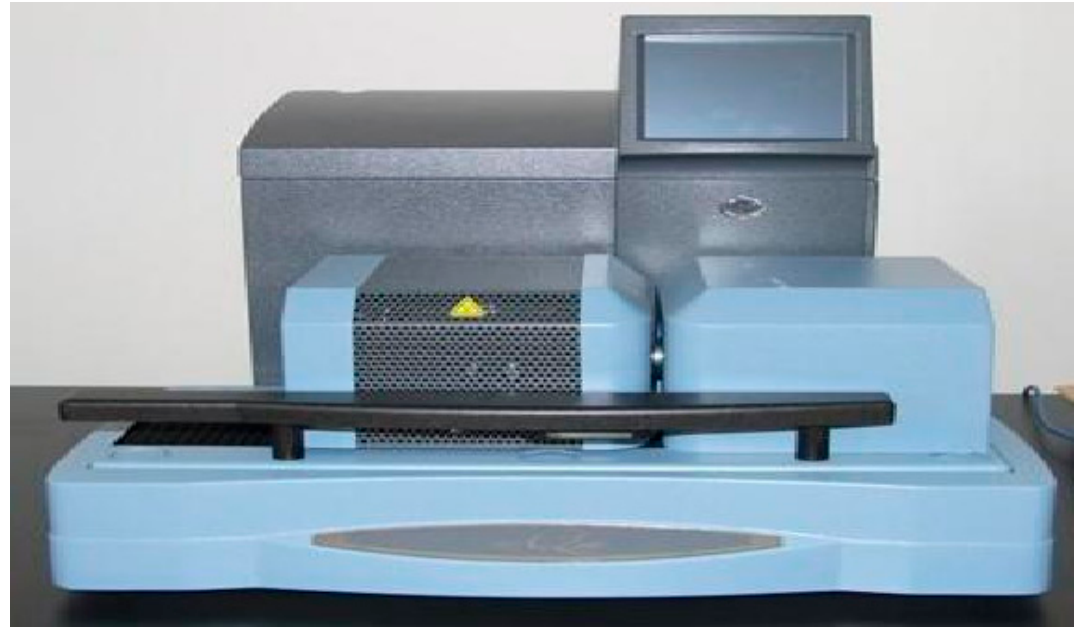
Figure 2. SDT-Q600 synchronous thermal analyzer.